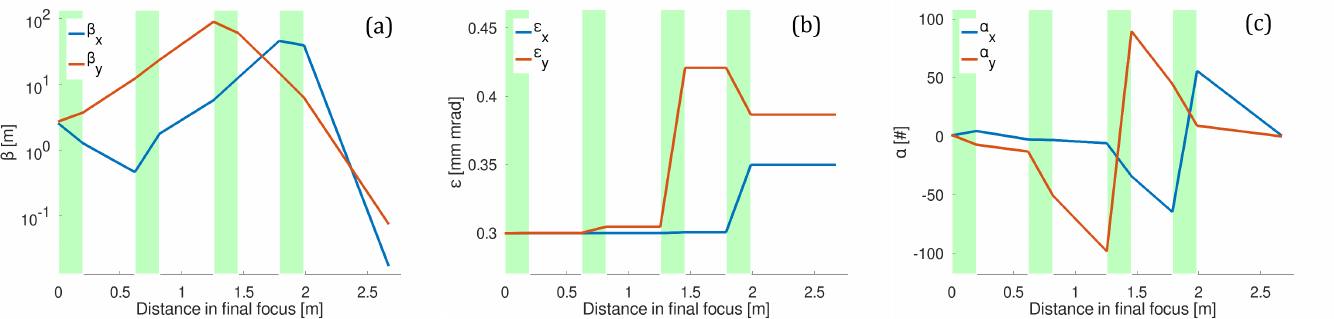
Figure 12. Tracking of optics functions across the distance travelled in the final focus. ( a ) Tracking of betatron function on a logarithmic scale. ( b ) Tracking of normalised emittance. ( c ) Tracking of alpha parameter. The quadrupoles are marked in